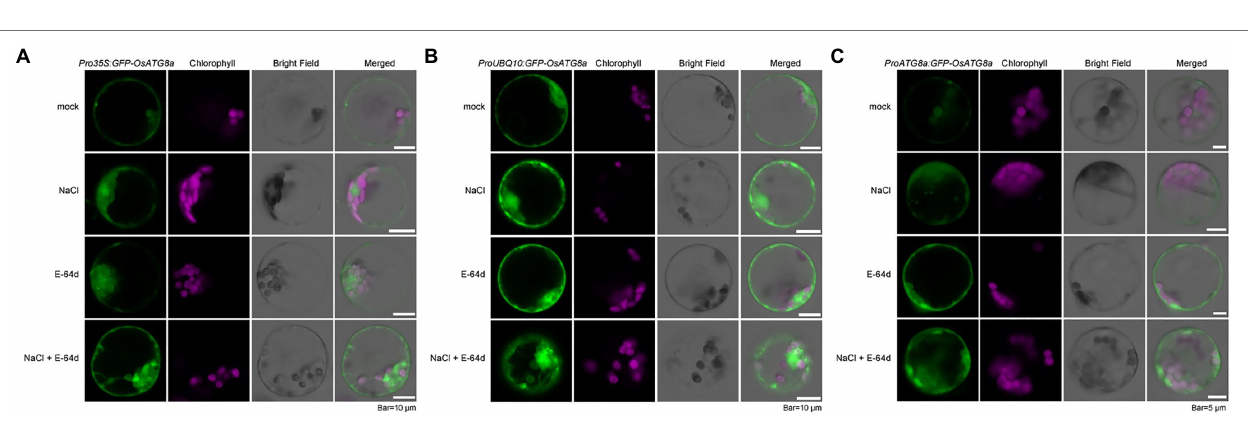
FIGURE 1 | Transient expression of constructs carrying GFP-OsATG8a . (A) Schematic representation of the GFP-OsATG8a fusion gene constructs. Three promoters—the CaMV35S promoter, the ubiquitin ( UBQ10 ) promoter, and the endogenous ( OsATG8a ) promoter—are used for the constructs. (B) LSCM of tobacco leaf epidermal cells transiently expressing GFP and GFP-OsATG8a. (C) Transient expression of GFP and GFP-OsATG8a in rice protoplasts. Puncta representing autophagosomes are indicated by yellow arrowheads in (B,C) . Bar = 10 μ m in (B,C) .